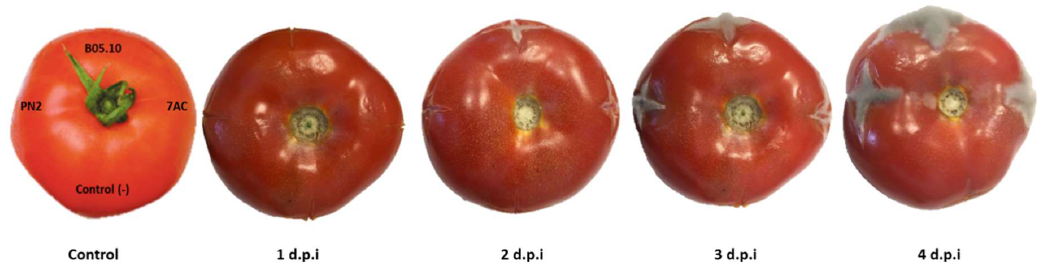
Figure 3. Virulence assay of damage produced by Botrytis on tomato after inoculating fruit with 10 µL of conidia suspension (2.5 × 10 6 conidia/mL) and incubated at 22 °C. Gamborg medium was used as negative control, whereas 7AC was used as positive control. Acronyms: B05.10, corresponds to a model isolate; PN2, corresponds to a multi-resistant native isolate; 7AC, corresponds to a native isolate resistant to fenhexamid (gift gently provided by Diagnofruit S.A. Santiago, Chile); dpi means days post inoculation.